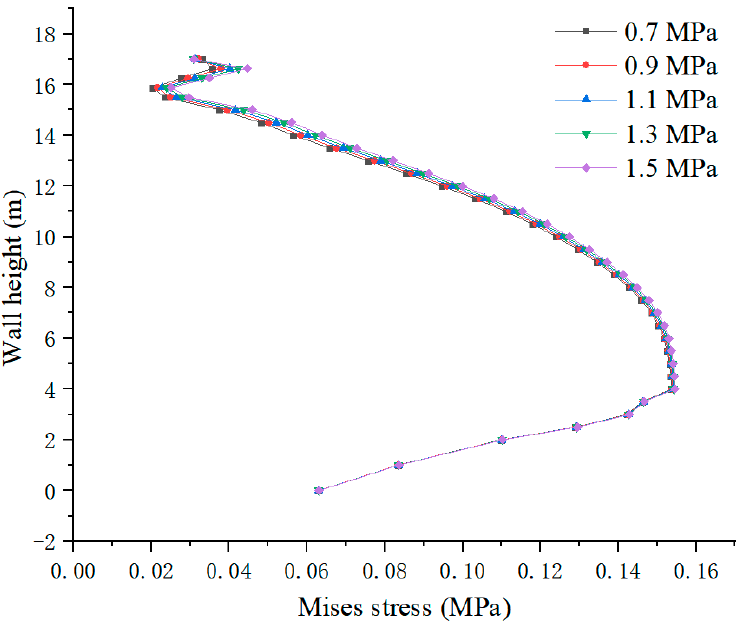
Figure 9. Distribution of Mises stress along the anti-seepage wall under different load amplitudes.